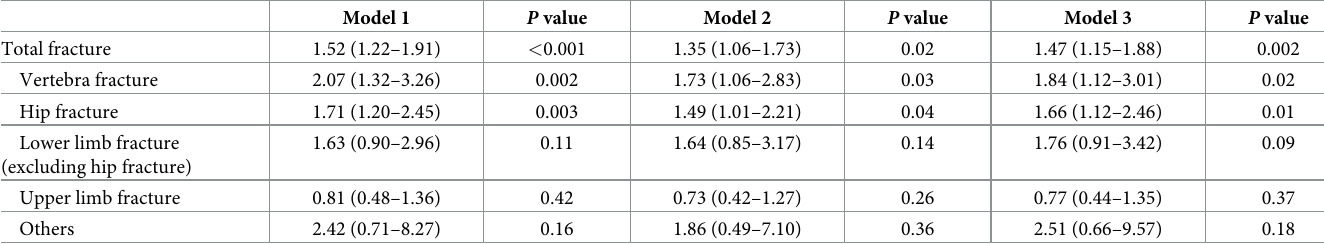
Table 3. Cox regression models for fracture risks of thiazide-associated hyponatremia patients compared to control patients. Model 1 P value Model